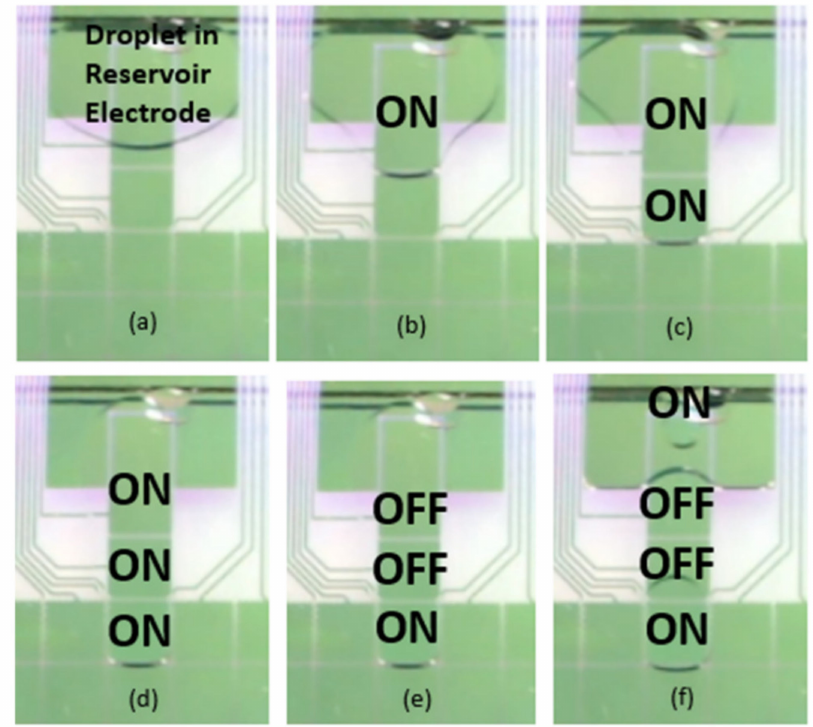
Figure 5. Real time discrete droplet generation in a DMF EWOD Chip. ( a ) represents the placement of droplet in reservoir electrode. In ( b ), generation electrode was turned ON. In ( c – e ), transportation electrodes were turned ON and OFF as per the quantity of droplet requirement. ( f ) shows the generation of droplet by turn ON the reservoir electrode. This figure is adapted from ref. [106] with permission from Springer